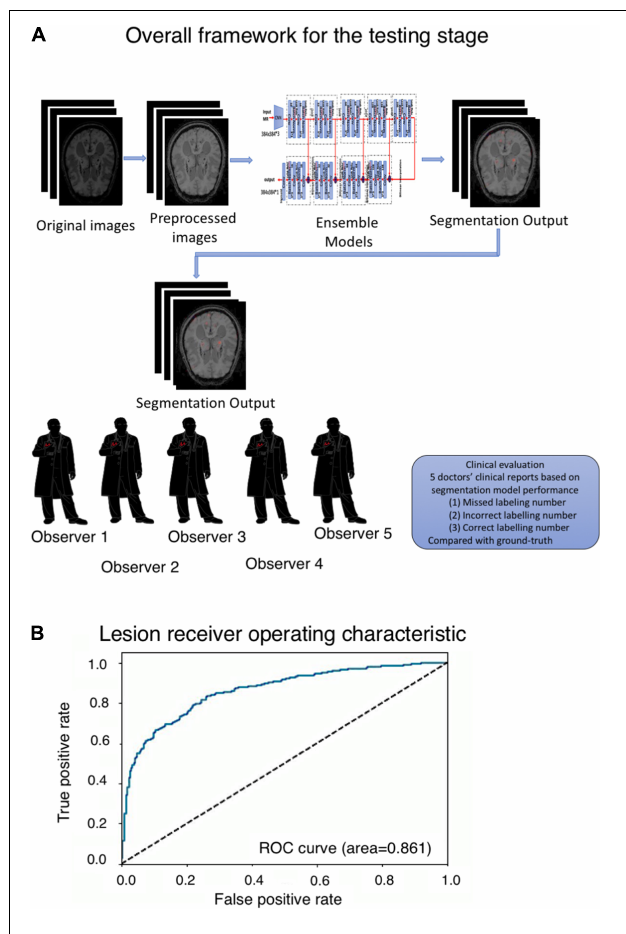
FIGURE 3 | (A) Overall framework for the testing stage. (B) Segmentation receiver operating characteristic (ROC) curve and area under the curve (AUC) score in the lesion level analysis.